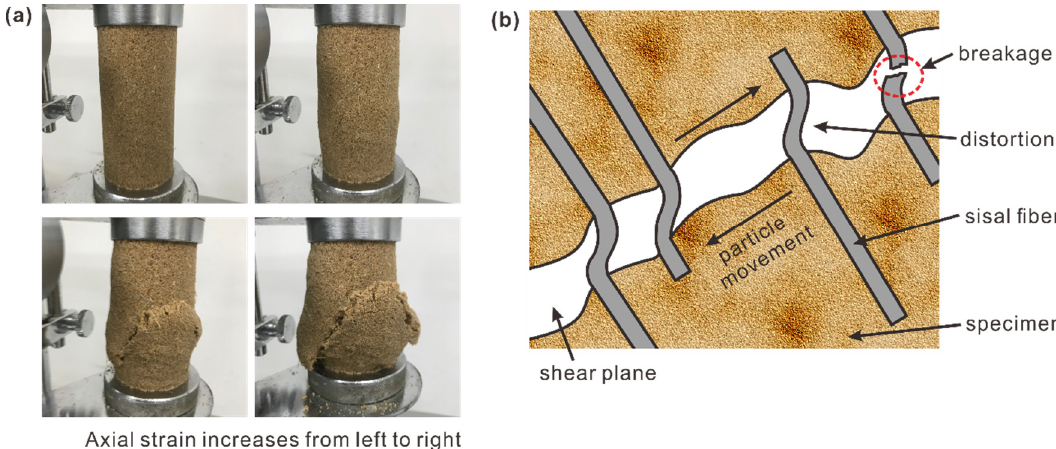
Figure 5. Results of fiber–polymer‐reinforced sand in the unconfined compression tests. ( a ) Photographs of specimens with the increase of axial strain during tests ( p f = 0.8%, p p = 1%, and ρ d = 1.5 g/cm 3 ); ( b ) Schematic drawing of fiber reinforcement in the test process.